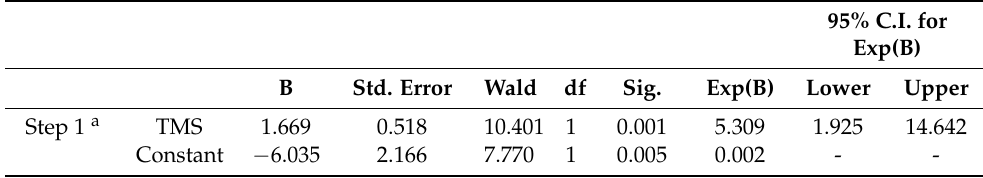
Table 21. Top management support: regression analysis for IaaS.